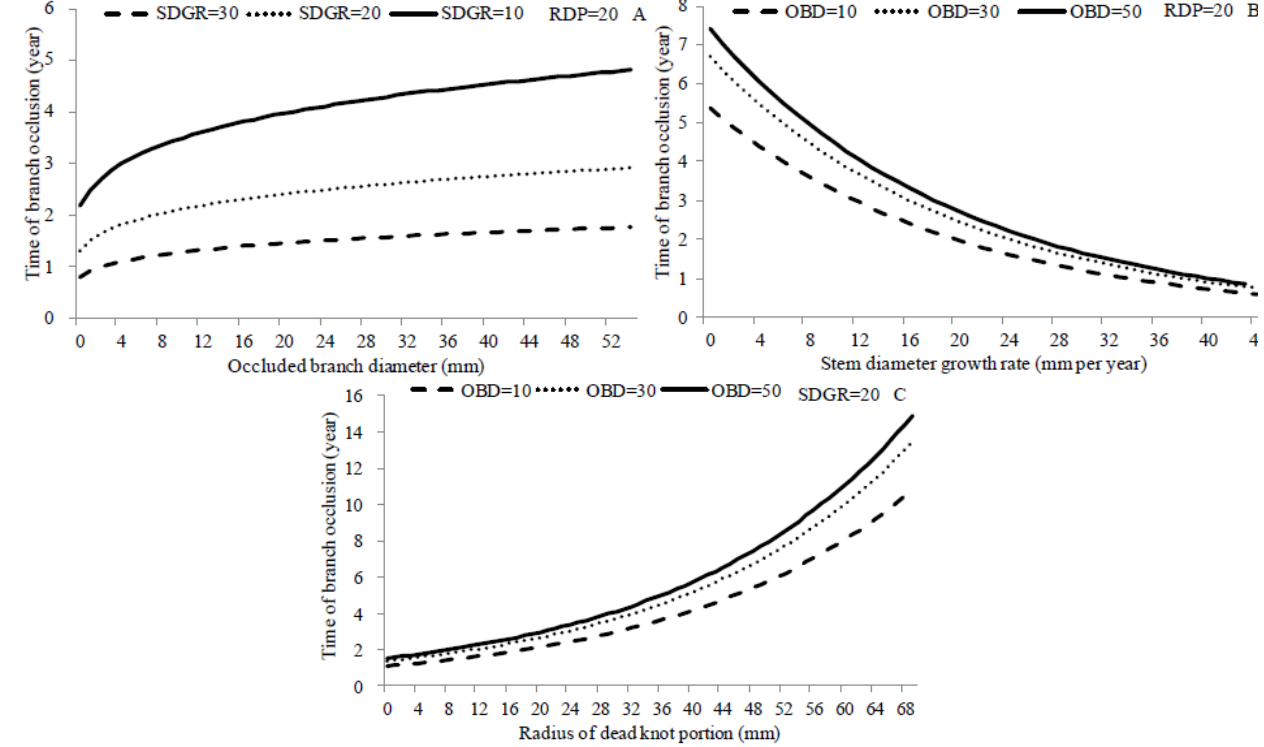
Figure 6. Predicted time of branch occlusion. ( A ) From three levels of stem diameter growth rates during branch occlusion (SDGR) and a radius of dead portion of knot (RDP) of 20mm plotted against occluded branch diameter (ODB) (Equation (1)); ( B ) from three levels of OBD and RDP of 20mm plotted against SDGR; and ( C ) from three levels of OBD and SDGR of 20mm year −1 plotted against